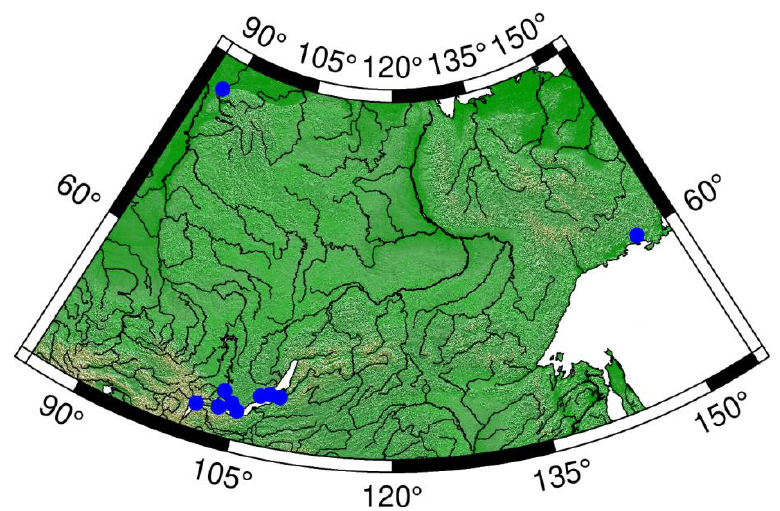
Figure 1. GNSS receivers within the ISTP SB RAS Siberian network ( SibNet ).